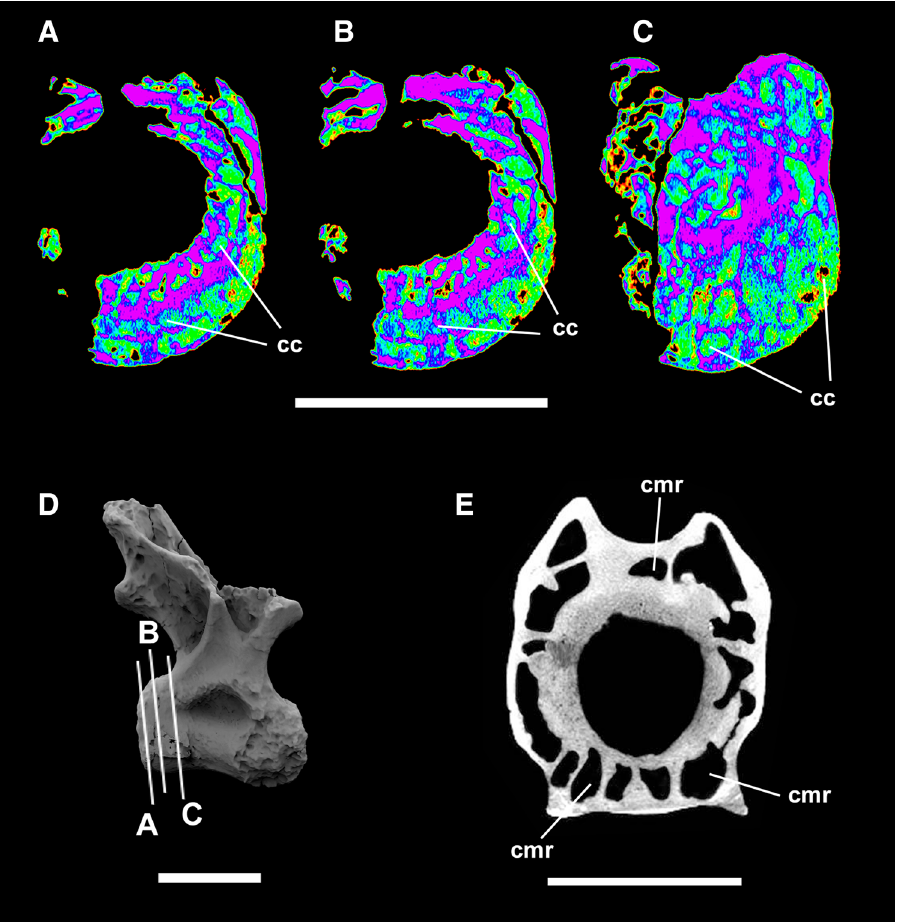
Figure 3. Dorsal vertebra centrum near the cotyle. Detail of internal structures of the saltasaurid titanosaur LPP-PV-0200 in A-C and comparison with Apatosaurus (OMNH 01094; from 47 ) in ( E ). Reconstructed tomography model in lateral view ( D ) illustrating CT scan slices in false color ( A – C ). Small circumferentially- arranged chambers are present in LPP-PV-0200 near the cotyle. A similar condition has previously been documented in the camerate vertebra of Apatosaurus ( E ). cc circumferential chambers, cmr radially arranged camerae. Scale bar 10 cm. Computed tomography data processed with 3D Slicer version 4.10. Figures were generated with Adobe Photoshop CC version 22.5.1 X64.